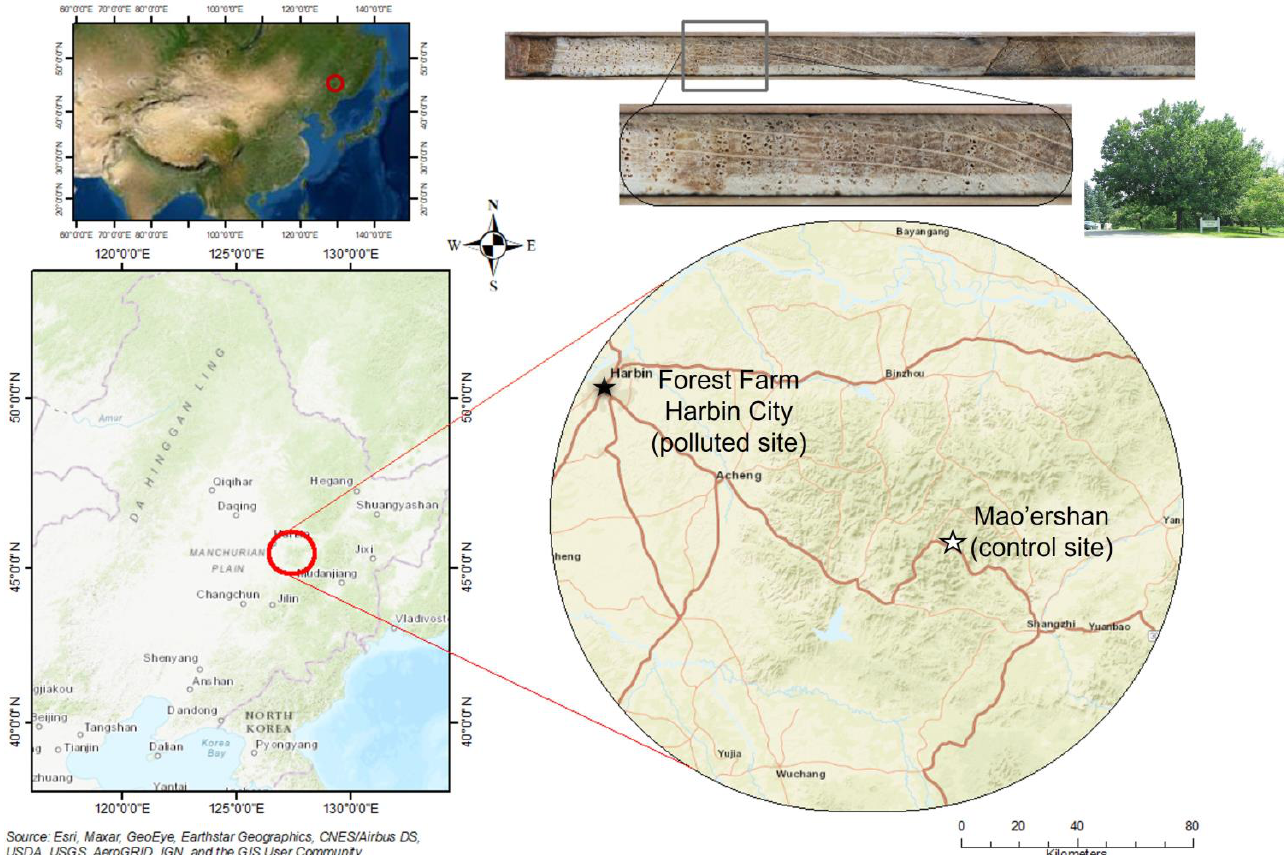
Figure 1. Sampling sites in the northeast Heilongjiang Province (Harbin as polluted site—black star, Mao’ershan as control site—white star) and example of ring-porous Quercus mongolica tree core used in this study.